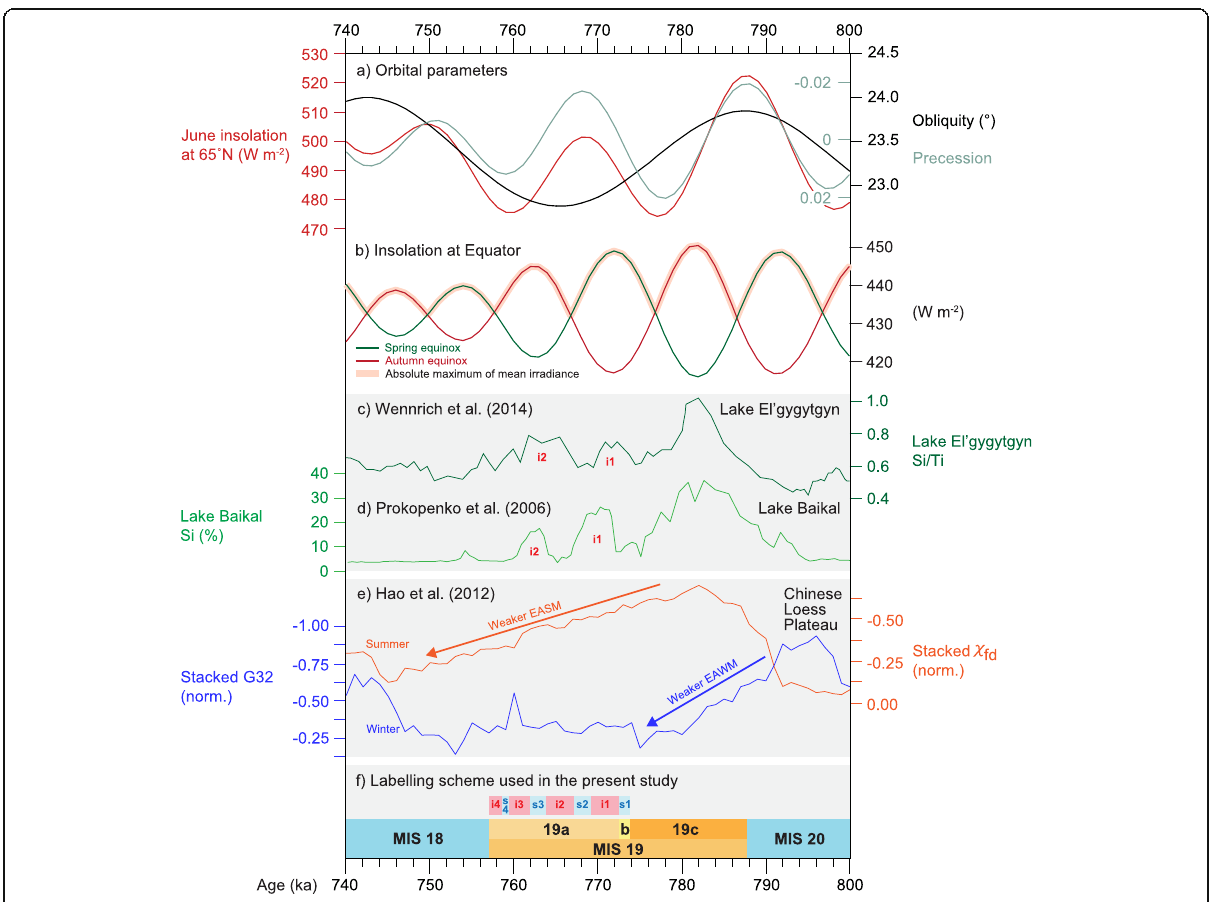
Fig. 12 Selected Asian records of Marine Isotope Stage 19. ( a ) Insolation at 65° N in June, and precession and obliquity parameters. ( b ) Insolation at Equator in spring and autumn, and absolute maximum of mean irradiance (Laskar et al. 2004; Ferretti et al. 2015; Haneda et al. 2020b). ( c ) Lake El ’ gygytgyn, northeast Siberia: XRF core scanning-derived Si/Ti ratio (Wennrich et al. 2014). ( d ) Lake Baikal, southern Siberia: Biogenic silica contents (Prokopenko et al. 2006). ( e ) Normalized Yimaguan and Luochuan (China) stacked loess – palaeosol proxy records for East Asian Summer Monsoon (EASM; frequency-dependent magnetic susceptibility, orange line) and East Asian Winter Monsoon (EAWM; > 32 μ m particle content, blue line) (suppl. fig. 12 of Hao et al., 2012). ( f ) The MIS 19 subdivisional scheme used here (Fig. 7): interstadials i1 and i2 are labelled in red. All records are plotted on their own published time